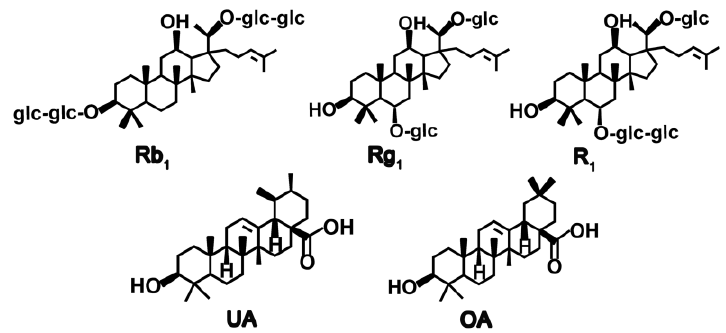
Figure 2. Molecular structures of Rb 1 , Rg 1 , R 1 , UA and OA.